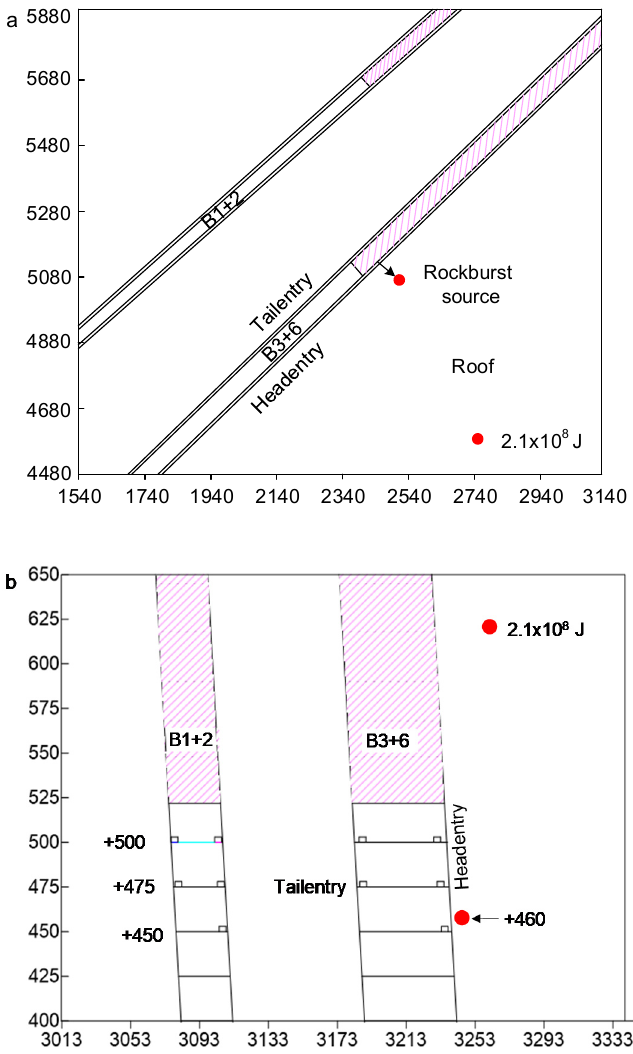
Figure 11. Location of the rockburst source that occurred on 1 February 2017: ( a ) plan for the source distribution and ( b ) elevation for the source distribution.